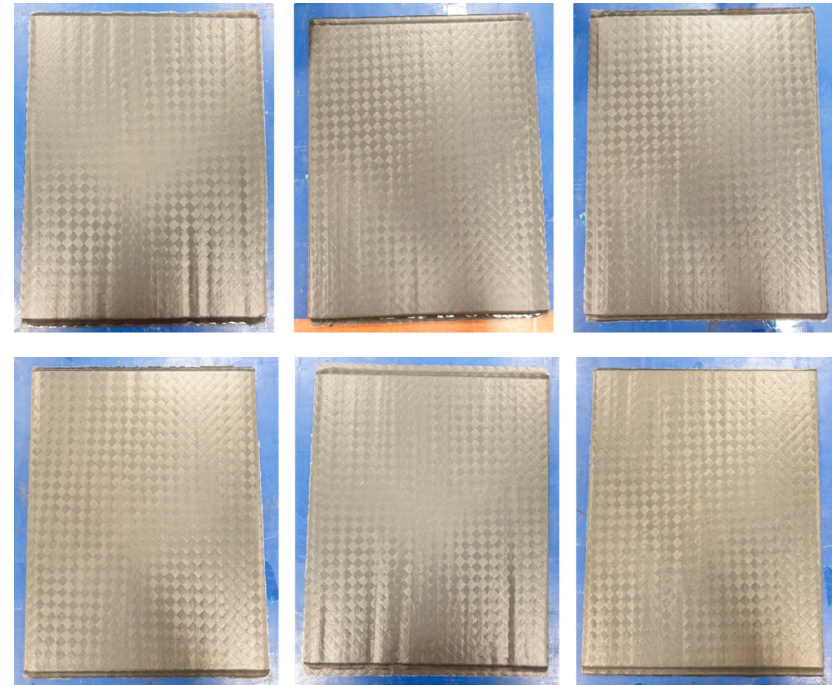
Figure 4. Laminates fabricated to obtain tensile specimens (TY1_A to TY6_A) and bending specimens (TY1_B to TY6_B).